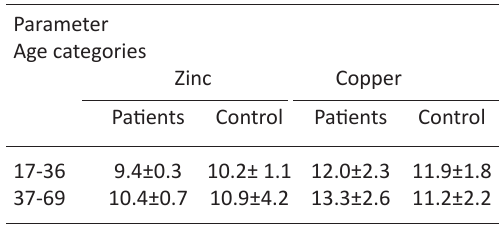
Table 4. Zinc and copper concentration (mmol/l) in patients with Brucellosis and healthy control.